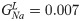
Long-term changes in concentrations of various ionic species in the model interneuron from NTG mice (GNaL=0.007 mS/cm2) in response to external stimulus during simulations shown in Fig 4a.(a) [Na+]i, (b) [Cl−]i, (c) [K+]o, (d) [Na+]o, (e) [Cl+]0, and (f) [K+]i. Inset shows enhanced view of changes in ionic concentrations at the time of applied stimulus.